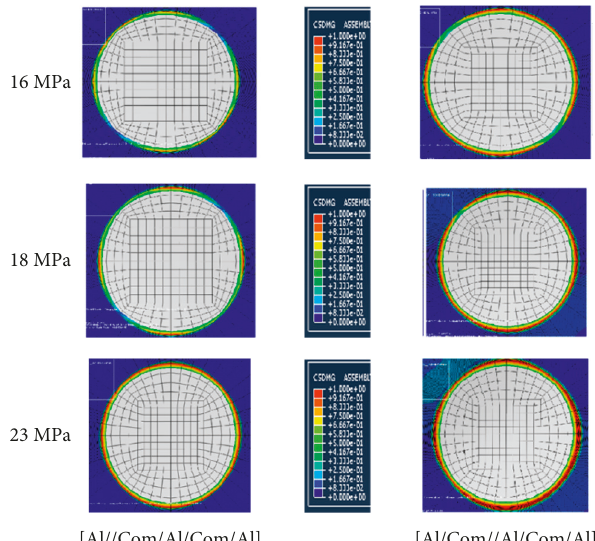
Figure 8: Contour plots of delamination growth of GLARE 3-3/2- 0.2 in different shear load